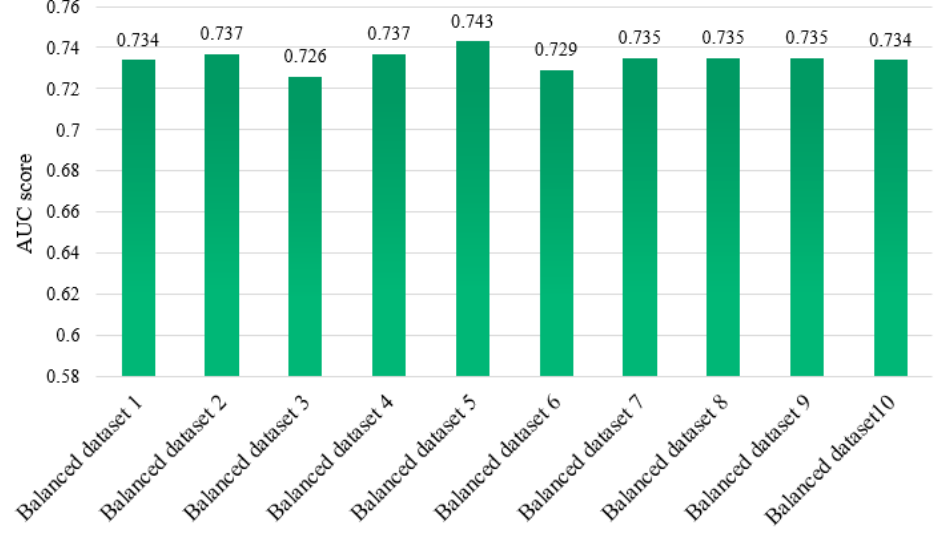
Figure 2. Area under the receiver operating characteristic (ROC) curve (AUC) scores for our classifier trained on 10 balanced datasets.